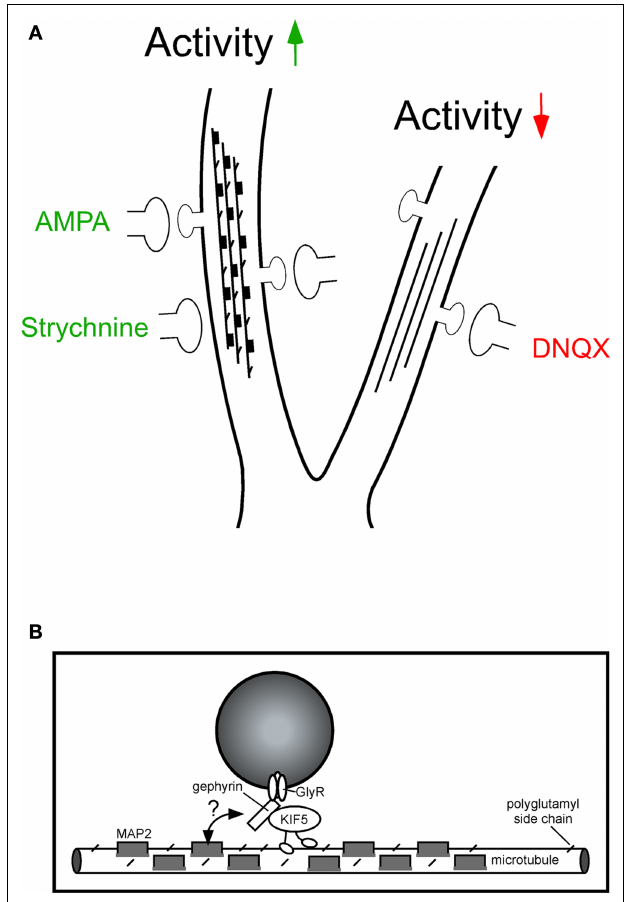
FIGURE 3 | Activity-dependent polyglutamylation of tubulin alters intracellular transport. (A) Model of microtubule track changes through polyglutamylation (diagonal lines) and MAP2 binding (dark squares) upon altered neuronal activity. Increased activity, as induced through GlyR blockade (strychnine) or AMPAR activation (AMPA), interferes with gephyrin delivery into distal neurites (left). This effect is not observed upon neuronal activity reduction through AMPAR blockade (6,7-Dinitroquinoxaline-2,3-dione, DNQX) and can be prevented through functional depletion of neuronal polyglutamylase (the respective enzyme that adds polyglutamyl side chains to tubulin). Although it is unclear which modifi cation is dominant, both represent negative signals for cargo delivery. (B) The individual cargo adaptor in the motor-cargo complex (gephyrin) is thought to mediate specifi city of transport, as individual motor proteins transport multiple cargoes. Notably, KIF5- mediated transport of gephyrin is signifi cantly reduced under strychnine conditions, whereas KIF5-mediated transport of GRIP1 (another cargo adaptor driven by the same motor) remains unaltered. The individual cargo adaptor within the transport complex (gephyrin) is therefore a candidate factor to sense modifi cations at the microtubule track surface (double arrow, question mark). Modifi ed after Maas et al.